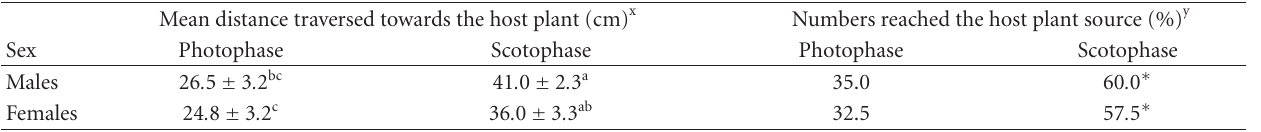
Figure 4: (a), Mean distance traversed by locusts during the 30 min observation period. Columns marked with di ff erent letters are significantly di ff erent ( P < . 05, Tukey’s studentized range test). (b), proportion of insects that took o ff within the first 5min of observation and (c), those that did not take o ff during the observation period. Table 2: Comparison of the distance traversed and numbers that reached the host plant ( Heliotropium sp.) stimulus in photophase and scotophase. N = 80 insects used for each of the three